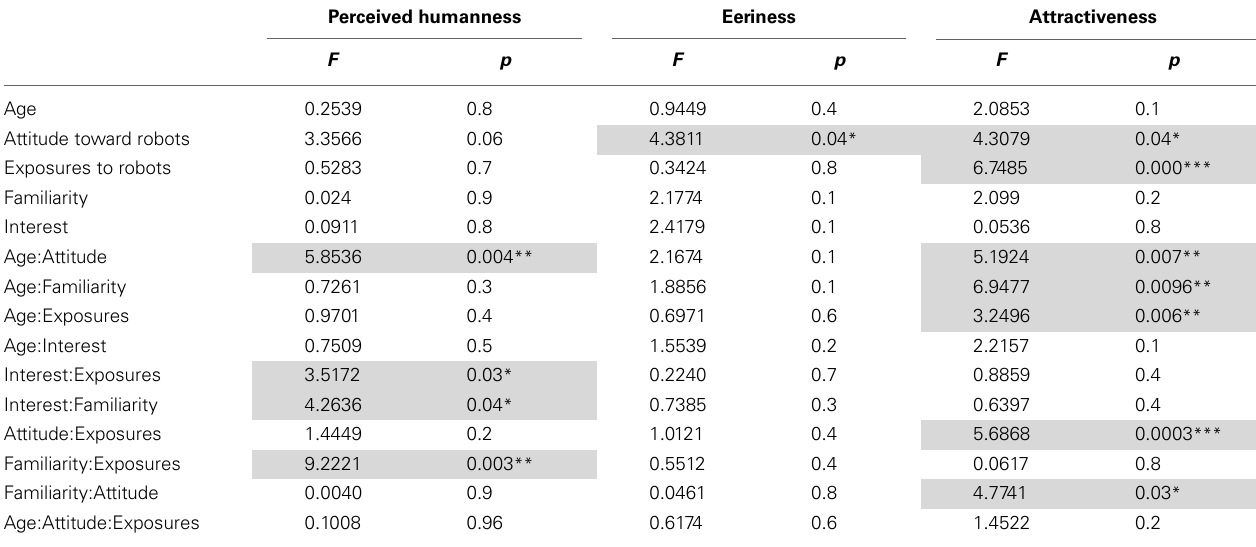
Table 3 | Attitudes and other factors influences on the perception of the